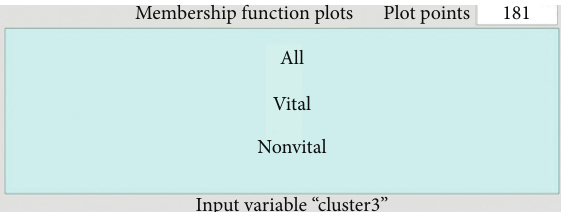
Figure 7: Output membership function for clusters.